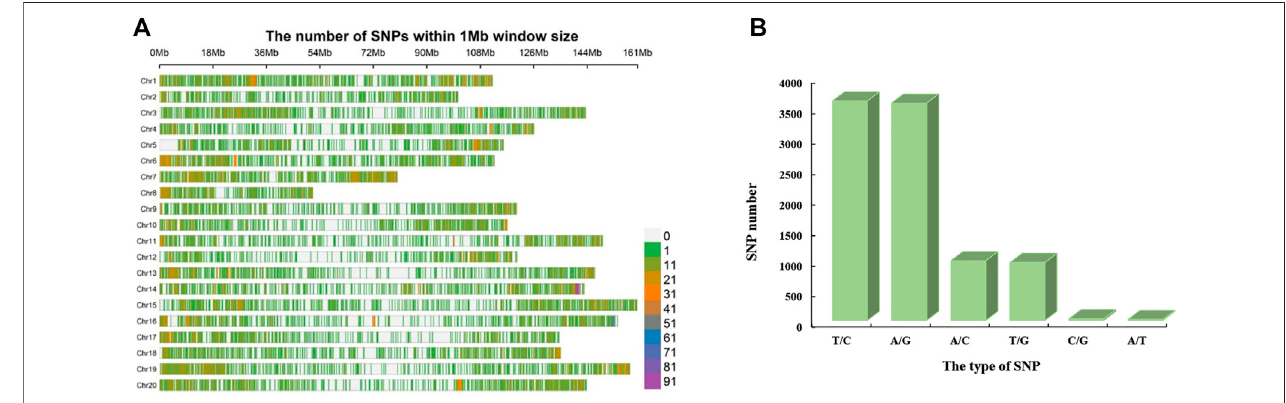
FIGURE 2 | Distribution and types of SNPs. (A) Distribution and density of SNPs in 20 peanut chromosomes. The horizontal axis shows the length of the chromosome (Mb), and the vertical axis represents 20 chromosomes. The shades of assorted color represent the SNP density on corresponding loci. (B) Frequency of several types of SNPs.